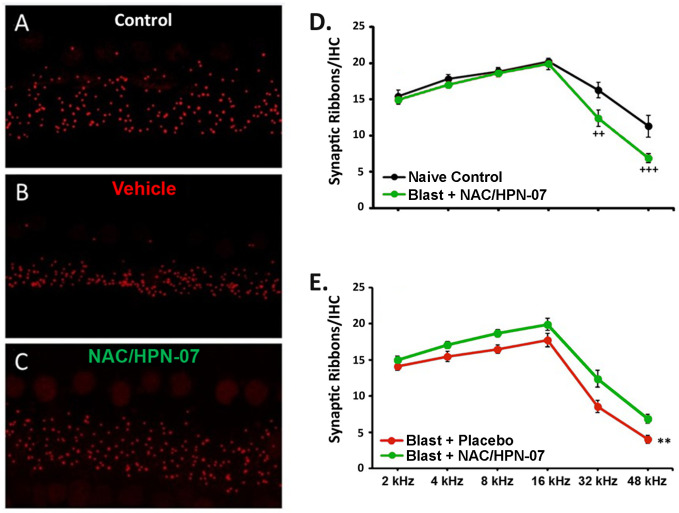
NAC/HPN-07 treatment rescued the blast-induced loss of IHC afferent synapses.A.–C. represent maximum projections from confocal z stacks of the IHC area in the 16 kHz region immunolabeled with antibody against CtBP2 (red) to show synaptic ribbons. D.-E. summarize mean (± SE) counts of presynaptic ribbons per IHC at each of the tonotopic positions for animals in each experimental cohort, as indicated in the symbol keys, where n = 12–23 ears/group. Data were obtained at approximately nine weeks after blast exposure. Statistical significance was determined by t-test with Holm-Bonferroni correction: ++
p < 0.01 and +++
p < 0.001, representing the simple effect of group at 32 and 48 kHz, respectively; by a mixed ANOVA: ** p < 0.01, the main effect of group.